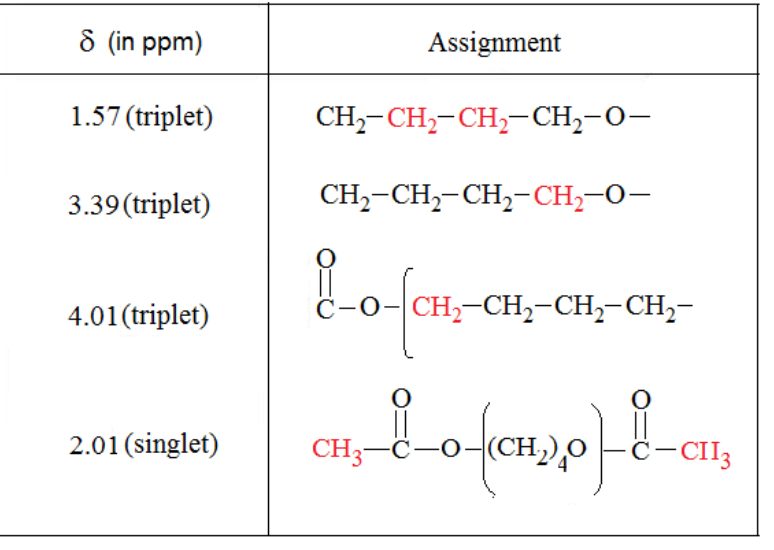
Table 1. Chemical shift of polymer protons.